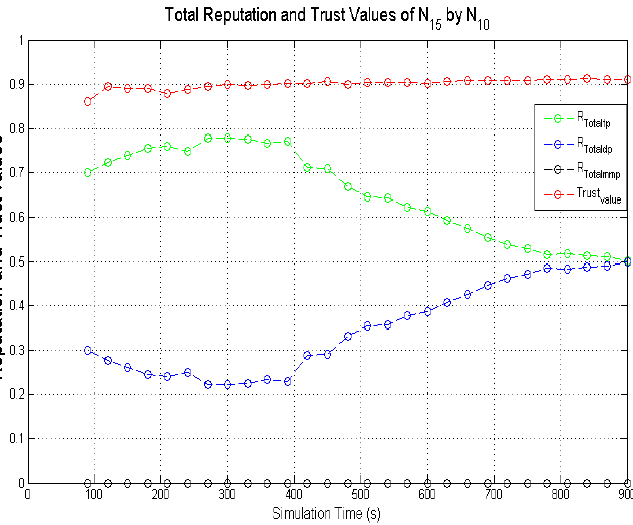
Figure 20. N 15 is low energy-constrained selfish and honest, N 10 is benevolent and honest.